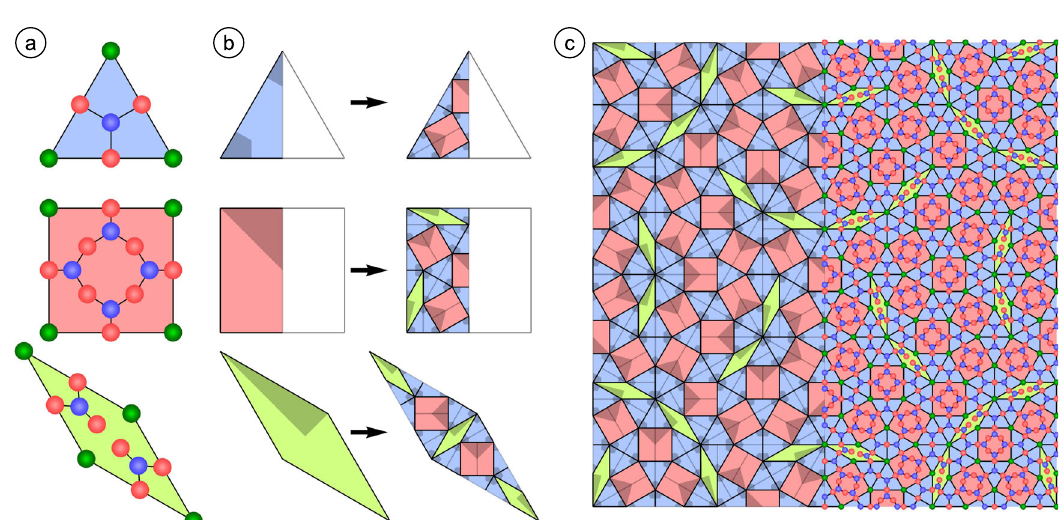
Fig. 3 | Generalization of the atomic structure to all related ternary oxides. a Decoration scheme for the three tiles of the oxide QC. Green, blue and red spheresrepresentA-side(SrorBa),Ti,andOatoms,respectively. b In fl ationrulefor the Niizeki-Gähler tiling of oxide quasicrystals based on three tiling elements. Shadedareasindicate the symmetryinherent to the tiling elements. The de fi nition